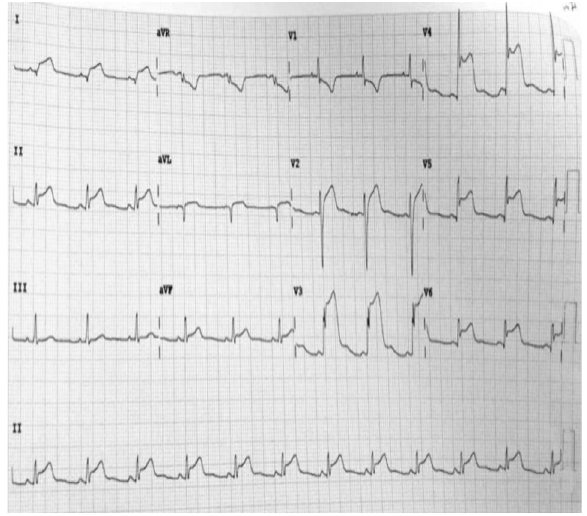
Figure 2. Repeated ECG shows worsening ST elevations from leads V2 –V6 without reciprocal changes.